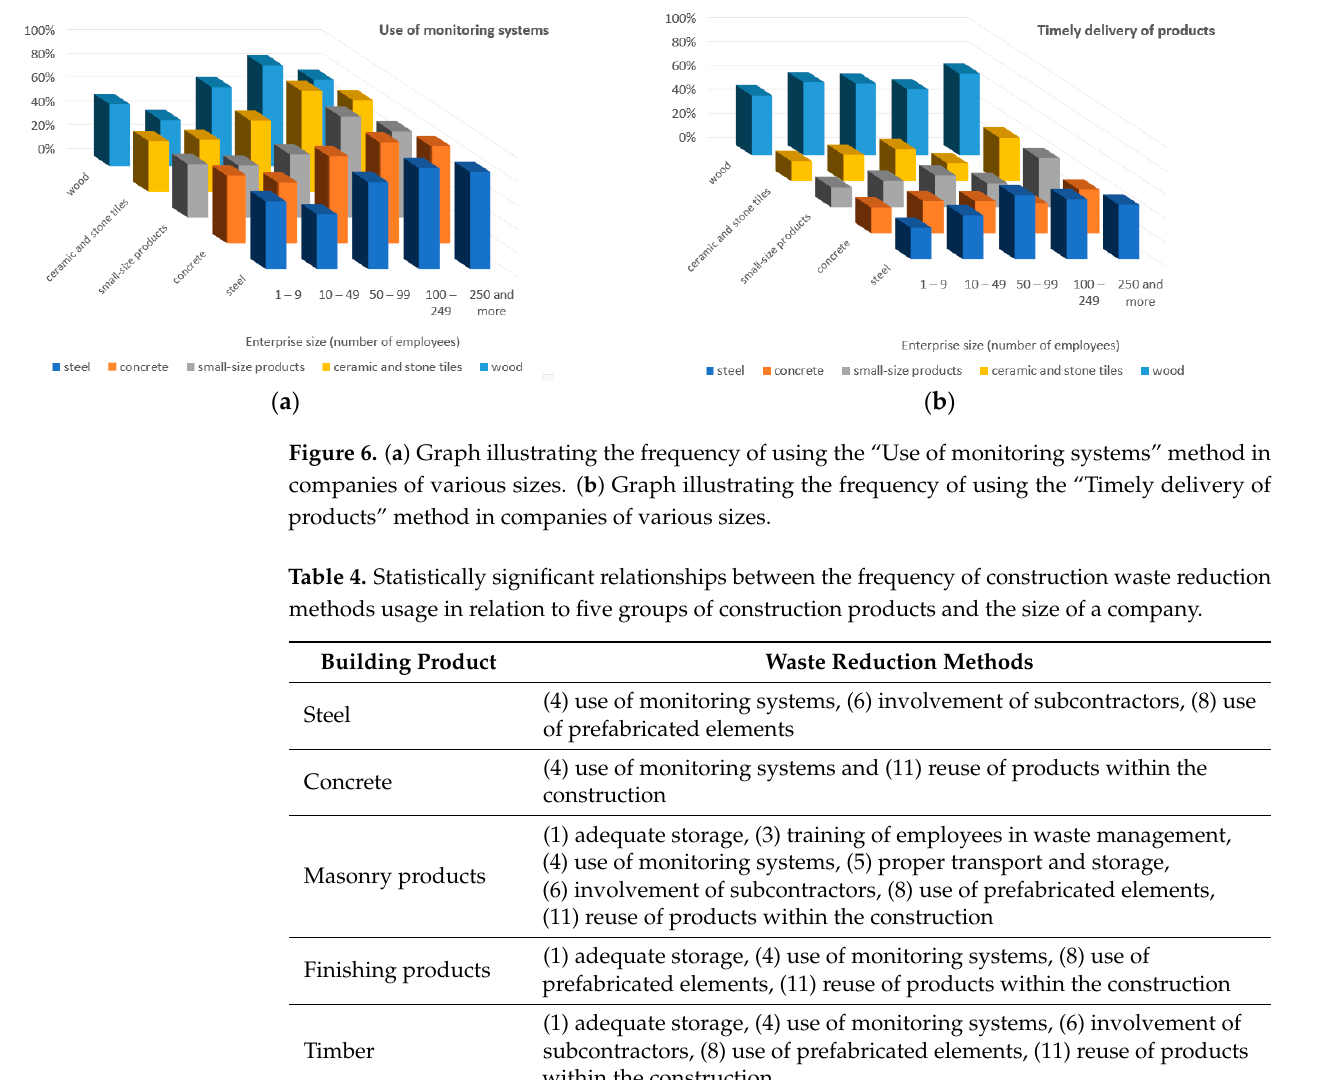
11 of 16 Table 3. Chi-square test statistics. No.